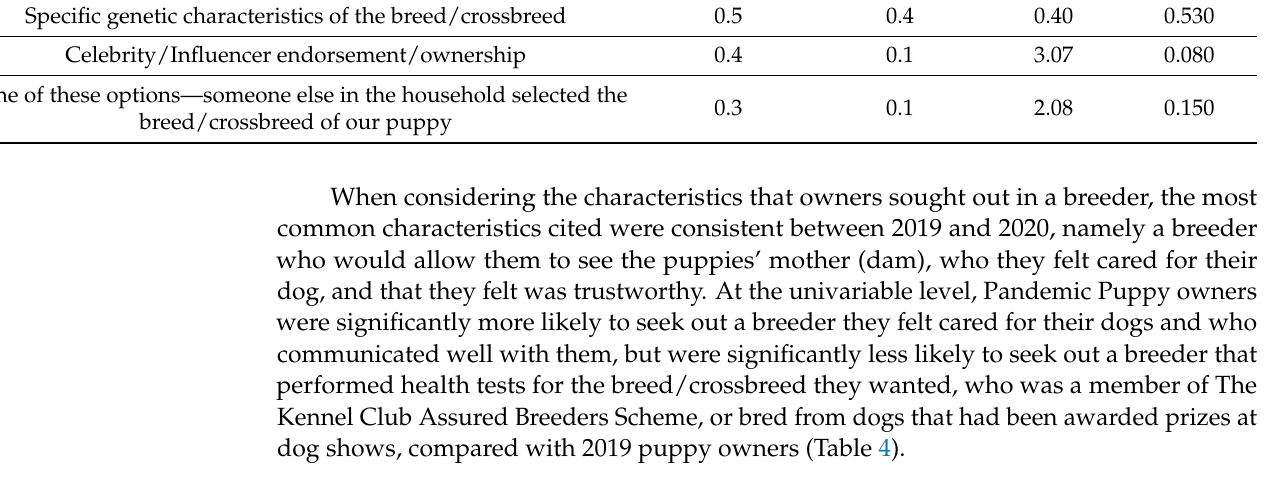
Table 4. Characteristics of breeders that prospective owners sought out, with comparisons between 2019 puppy ( n = 1101) and Pandemic Puppy owners ( n = 4178) in the